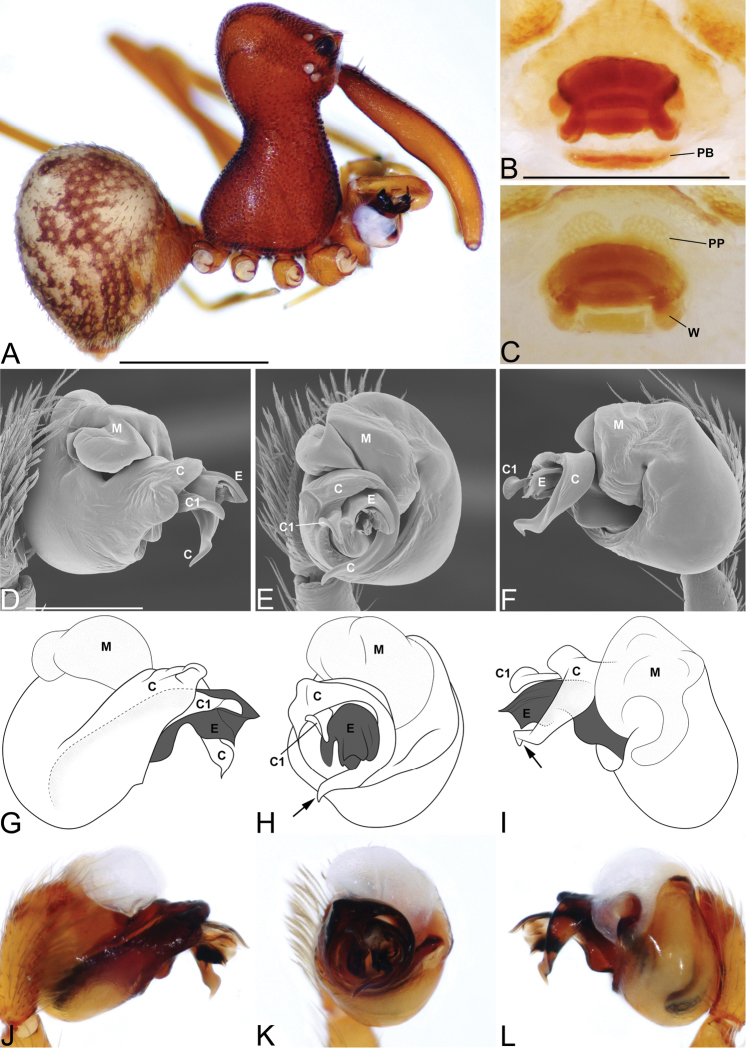

Eriauchenius
sama sp. n. A male (holotype, CASENT9012014) habitus, lateral view, image reversed B–C female (CASENT9012341) internal genitalia: B dorsal view C anterior view D–L male pedipalpal bulbs (holotype, CASENT9012014), arrow showing the change in direction in the curve of the conductor tip D–F right bulb, image reversed G–L left bulb D, G, J prolateral view E, H, K ventral view F, I, L retrolateral view. Scale bars: 1 mm (A); 0.25 mm (B, D).